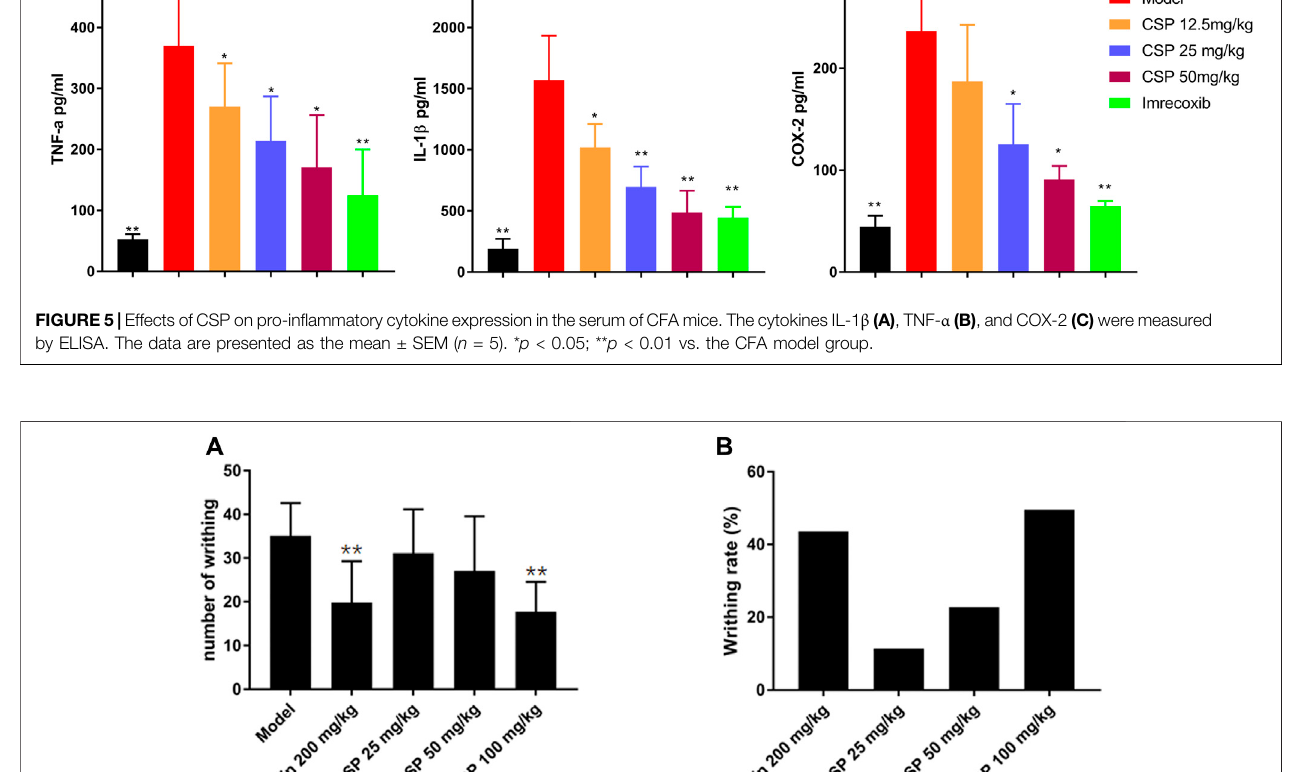
FIGURE6| EffectofCSPonaceticacidinducedwrithingmodelinmice. (A) Thenumberofwrithingduring15 min; (B) PercentageprotectionofCSPonaceticacid induced writhing model in mice. ** p < 0.01 compared with model group.